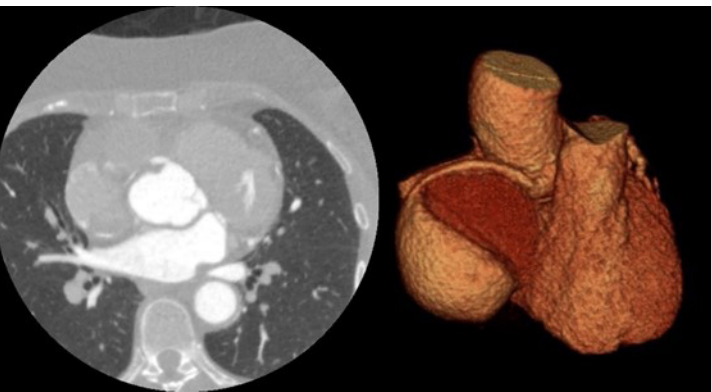
Fig. 1 - A) Coronary computed tomography angiography showing a saccular aneurysm with a partially calcified mural thrombus.